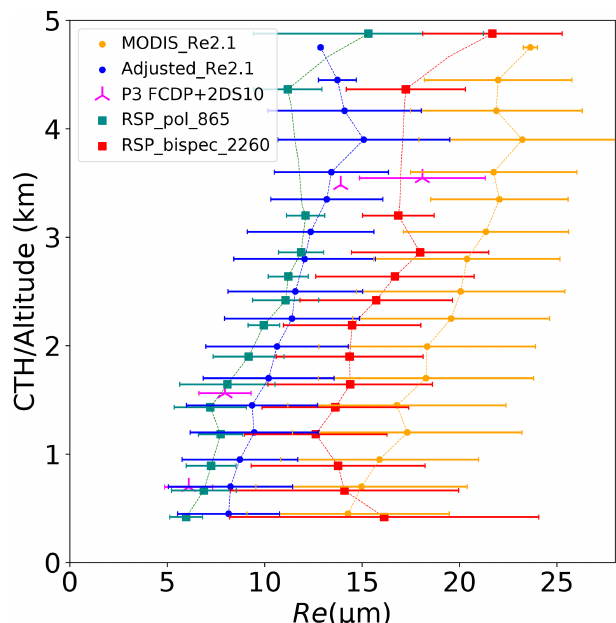
Figure 5. R e profile (mean R e vs. mean height) of vertically binned MODIS R e , bias-adjusted MODIS R e (after applying the Fu et al., 2019, correction factors), RSP polarimetric R e , RSP bi-spectral R e , and P-3 R e derived in situ for the RF02 case. Horizontal whiskers indicate the standard deviation of data within each 250m altitude